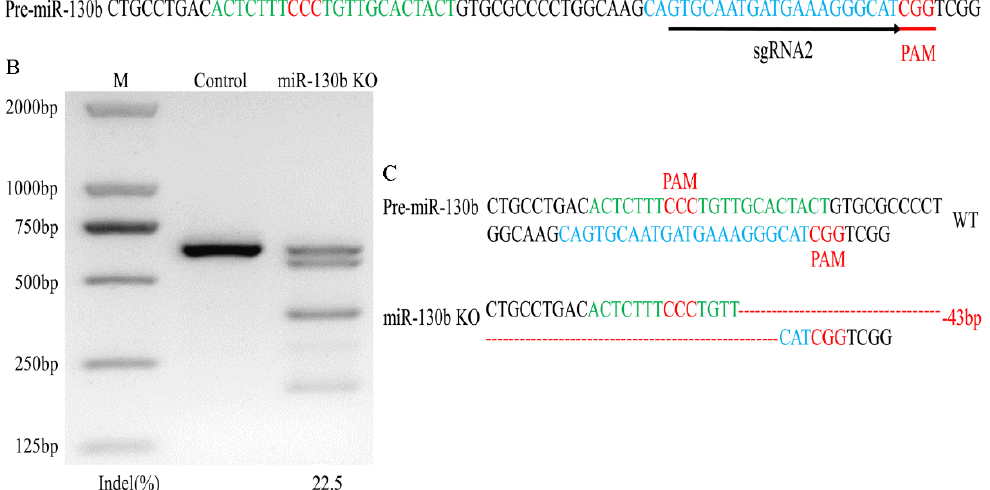
Figure 1. sgRNA targets the pre-miR-130b coding sequence in goat, and gene-editing analysis of single-cell clone. ( A ) Pre-miR-130b genomic sequence and its corresponding sgRNAs selection. sgRNA1 and sgRNA2 are displayed as horizontal arrowheads (black), and PAM sequences are underlined and in red. miR-130b-5p and miR-130b-3p genomic sequences are shown in green and blue, respectively. ( B ) Cleavage efficiency of the PCR product spanning pre-miR-130b sequence was detected via T7EN1 assay and the intensity of bands was calculated by ImageJ. ( C ) DNA sequencing confirmed the indels sequence in miR-130b alleles in the single clone. Wild type (WT) and nucleotide deletion (-) are displayed on the right and deleted nucleotides are indicated with a red dotted line.